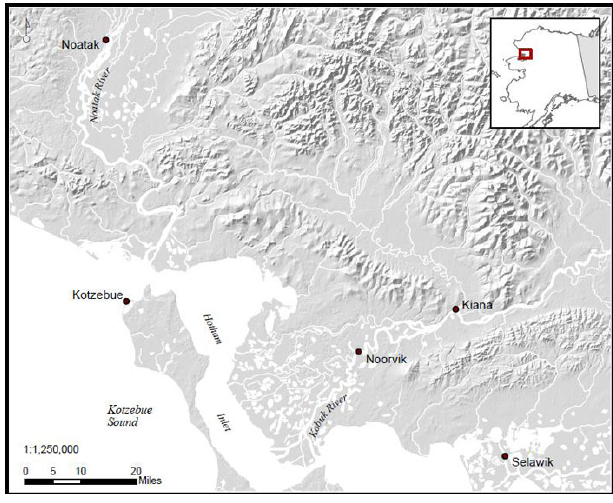
Fig. 1 . Research area: Selawik and Noatak in northwest Alaska. Image created by Nicole